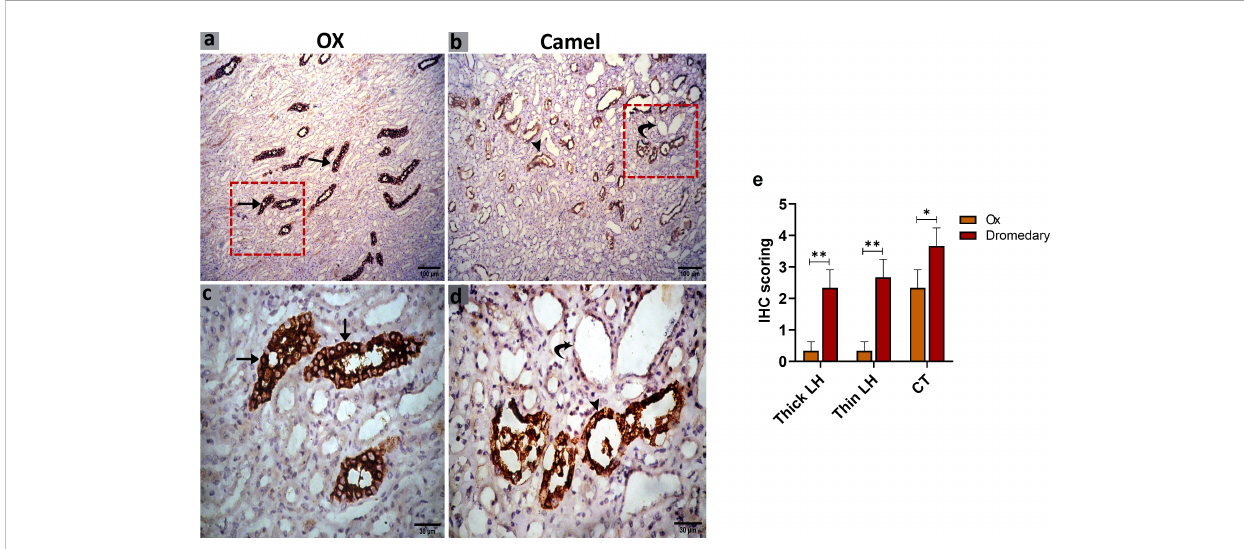
FIGURE 10 (A, C) Immunohistochemical analysis for AQP2 protein expression in the renal tissues of the oxen. a moderate expression in the epithelium lining the collecting tubules (CT, arrows) was noted. (B, D) Immunohistochemical analysis for AQP2 protein expression in the renal tissues of the dromedary kidney. A strong expression in the lining epithelium of CT (arrowheads) and moderate expression in the loop of Henle (curved arrows) was observed. (E) Expression scoring for the expression of AQP2 in kidneys of oxen and dromedaries. A minimum of 3 slides were assessed for each species. Data shown are represented as mean ± SD.* p <0.05, ** p